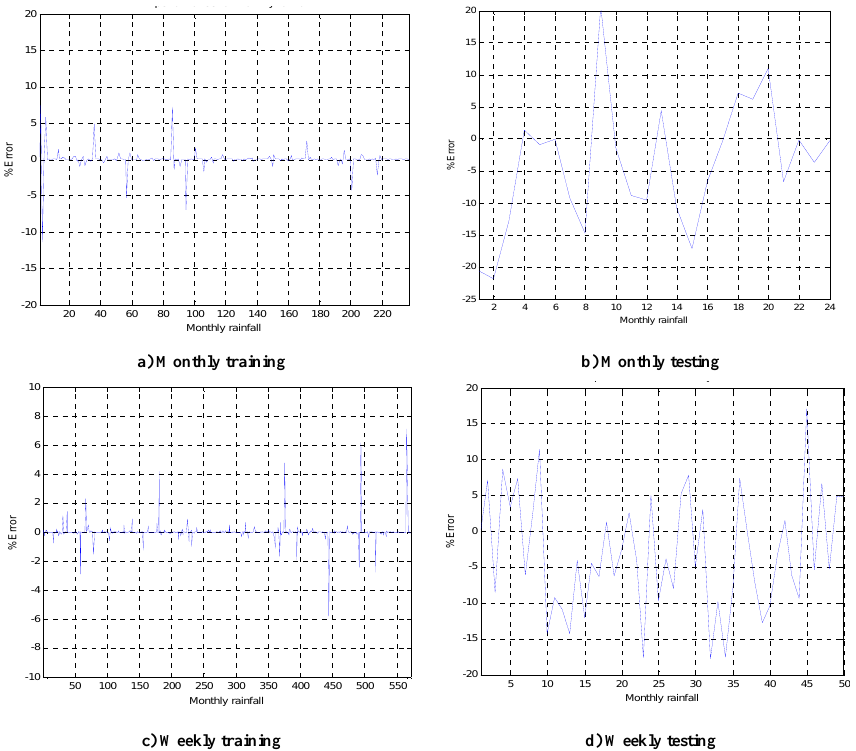
Fig. 15. Performance of the IDNN model for monthly and weekly rainfall forecasting during training and testing stages.